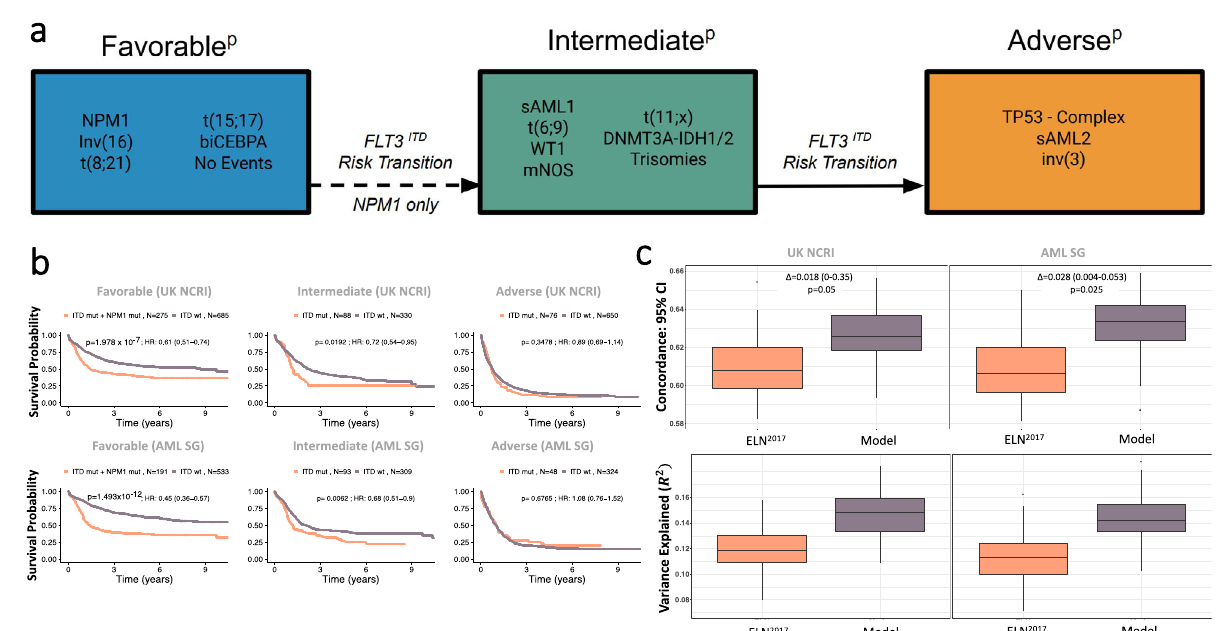
Fig. 5 | Establishment of a new risk proposal based on the AML classes. a Class assignment into one of three proposed risk categories (Favorable P , Inter- mediate P , Adverse P ) is based on class membership and FLT3 ITD status, whereby thepresenceof NPM1 and FLT3 ITD intheFavorable P ,thepresenceof FLT3 ITD inthe Intermediate P groups shifts one risk category to the Intermediate P and Adverse P respectively. NPM1 FLT3 ITD Patients classi fi ed as intermediate by class mem- bership with the presence of FLT3 ITD shift to adverse. The dotted arrow refers to the risk transition for patients with both NPM1 and FLT3 ITD mutations from favorable to intermediate. The solid arrow refers to the risk transition for patients with FLT3 ITD from intermediate to adverse. b Kaplan – Meier overall survival curves comparing each of the proposed risk strata (Favorable P , Inter- mediate P , Adverse P ) by the presence of NPM1 and FLT3 ITD status for the